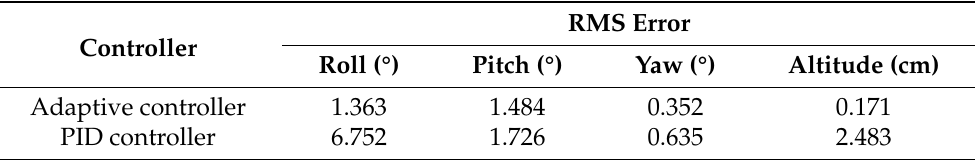
Table 2. Comparison of the RMS attitude and altitude errors from the adaptive controller and the PID